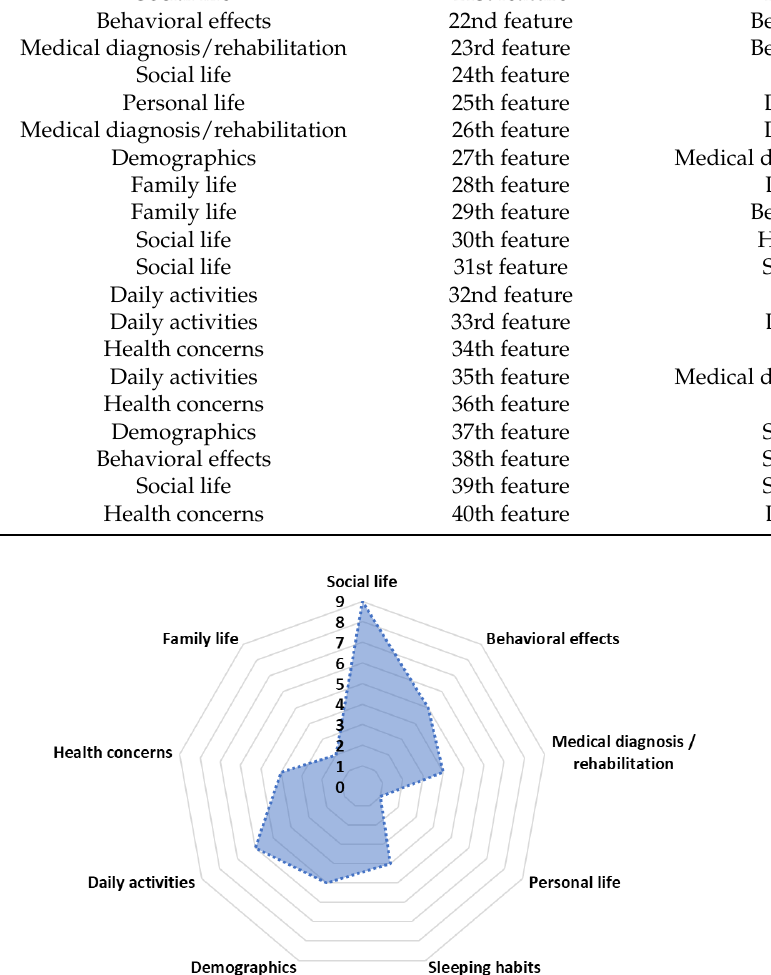
Figure 6. Classification results. Table 11. The maximum accuracy achieved from the classification models. The best performance is shown in bold. Models